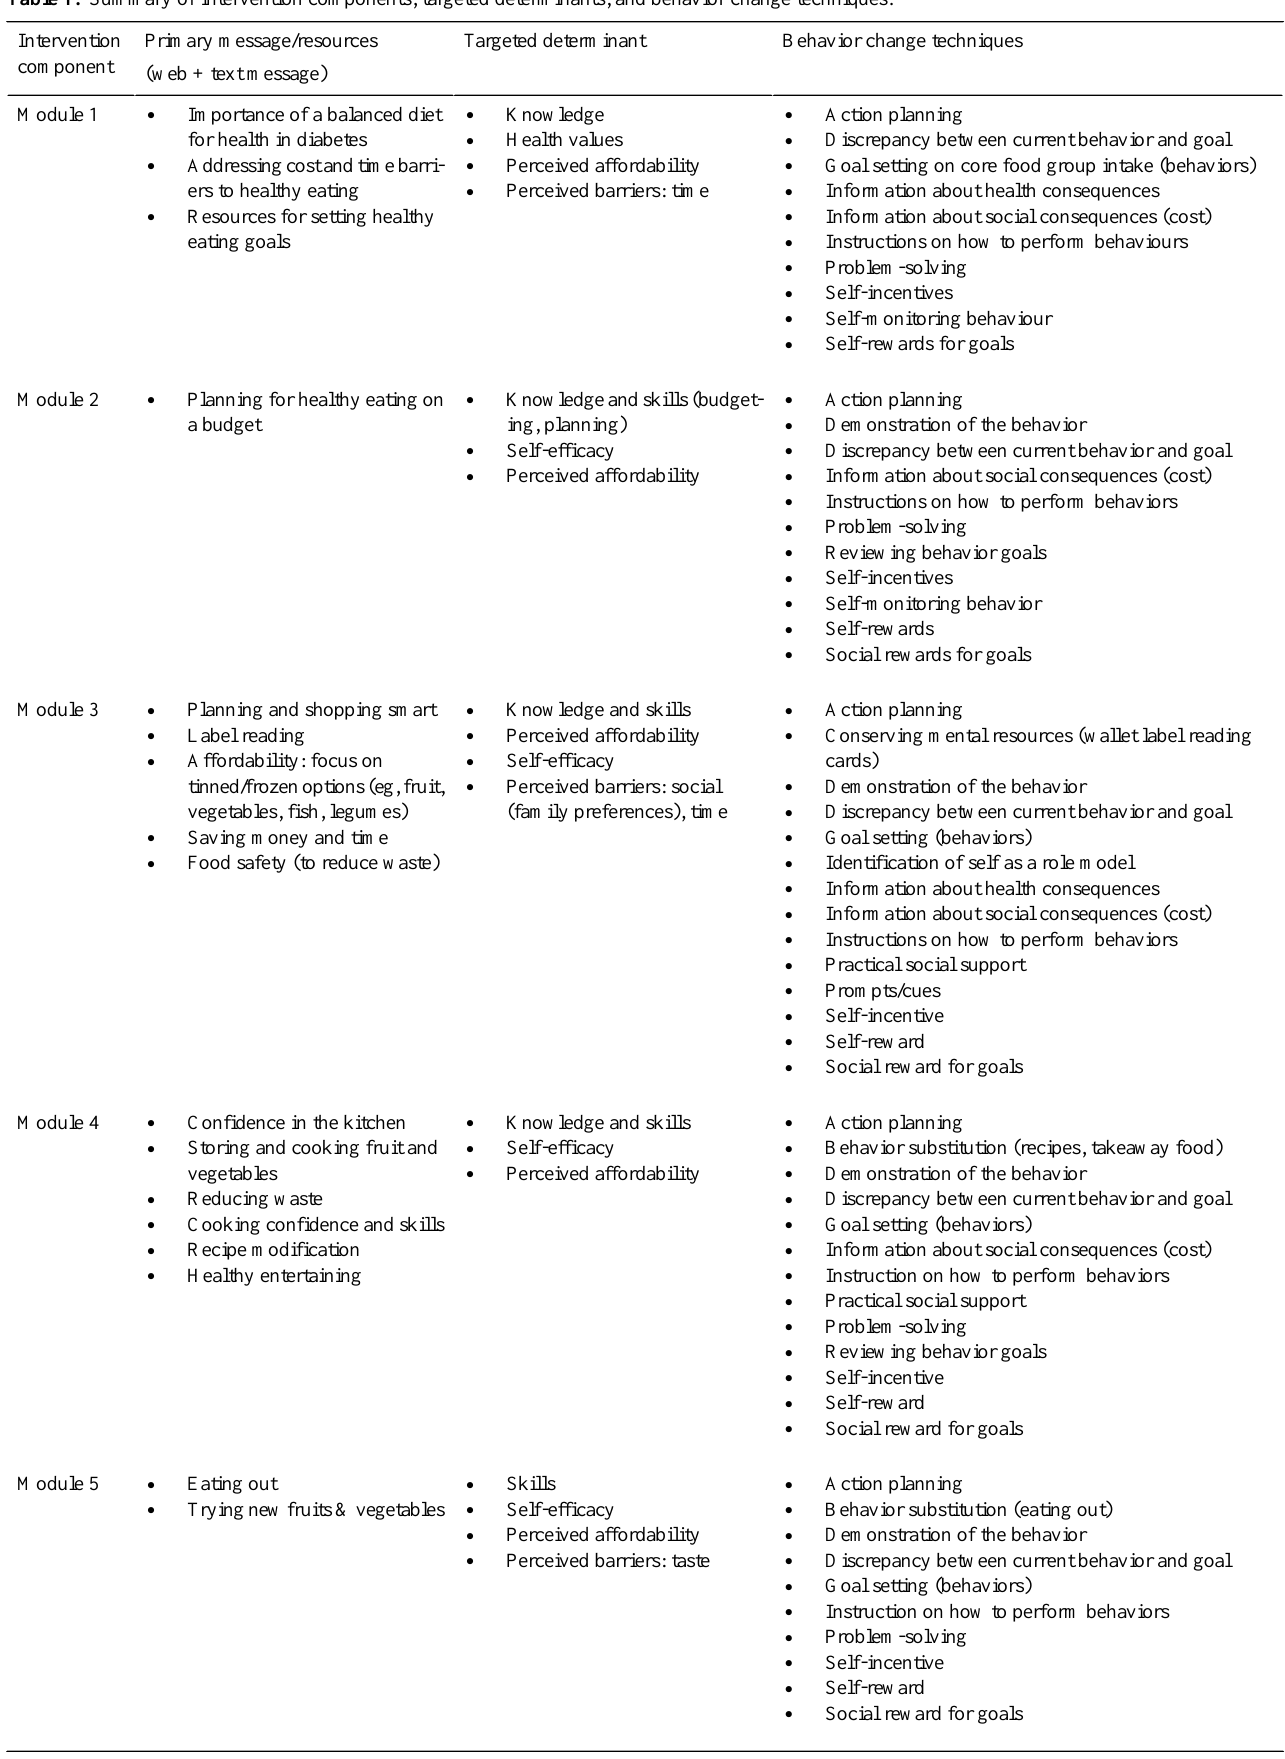
Table 1. Summary of intervention components, targeted determinants, and behavior change